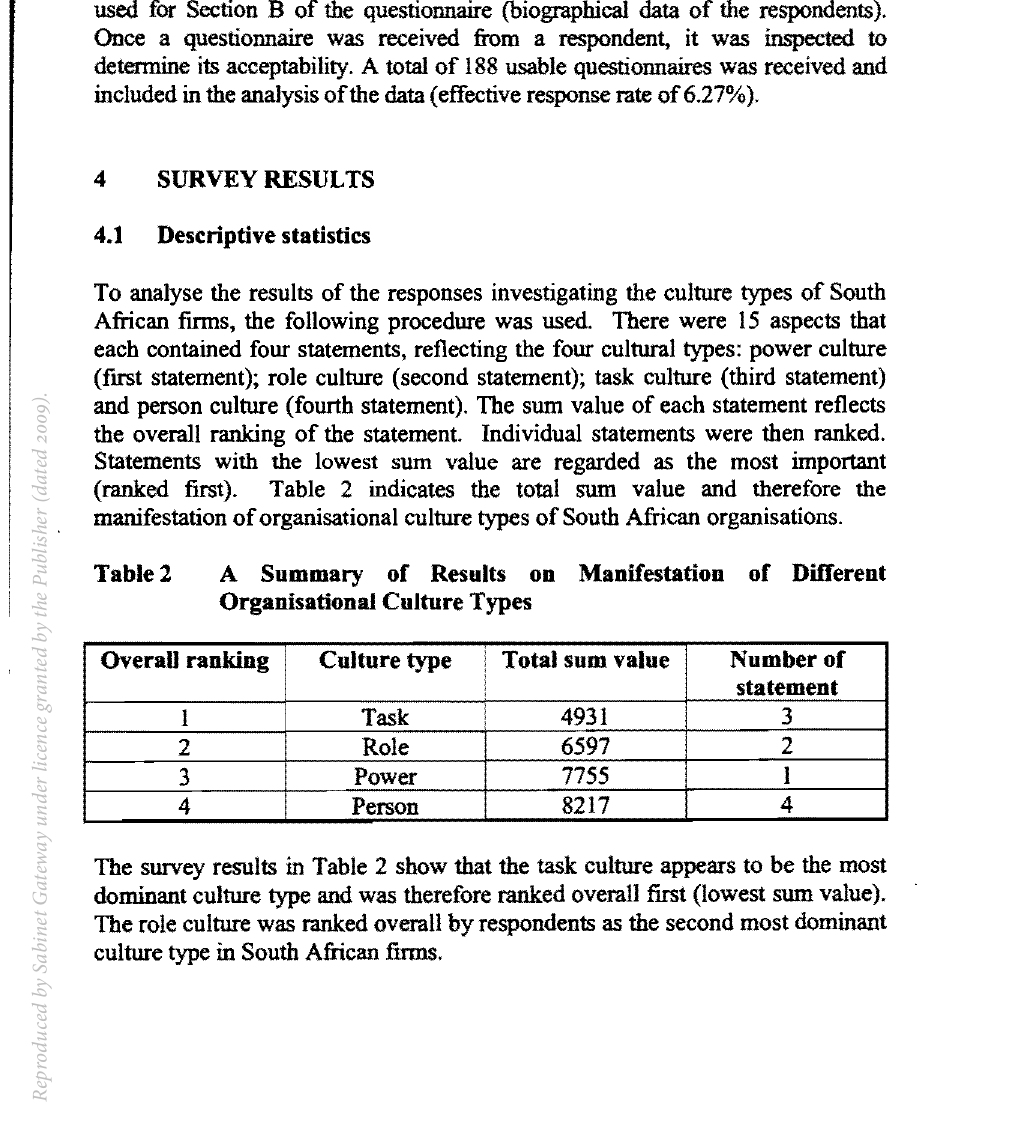
A Summary of Results on Manifestation of Different Organisational Culture